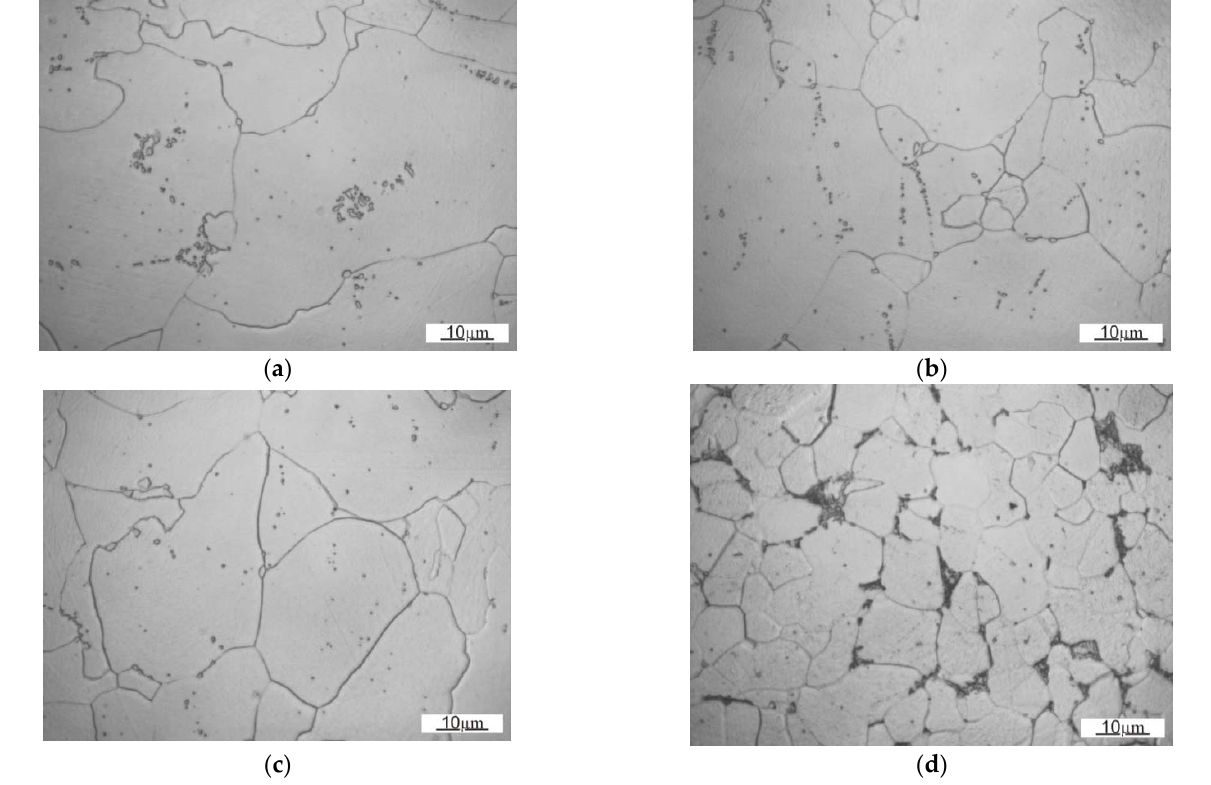
Figure 6. The microstructures of the investigated steel sheets in the rolling plane (RD-STD): ( a ) DC03; ( b ) DC04; ( c ) DC05; ( d ) DD14. Table 7. Hardness HV10 of the investigated steel